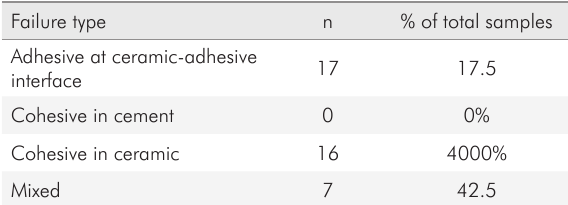
Table 4. Percentage of failure types.